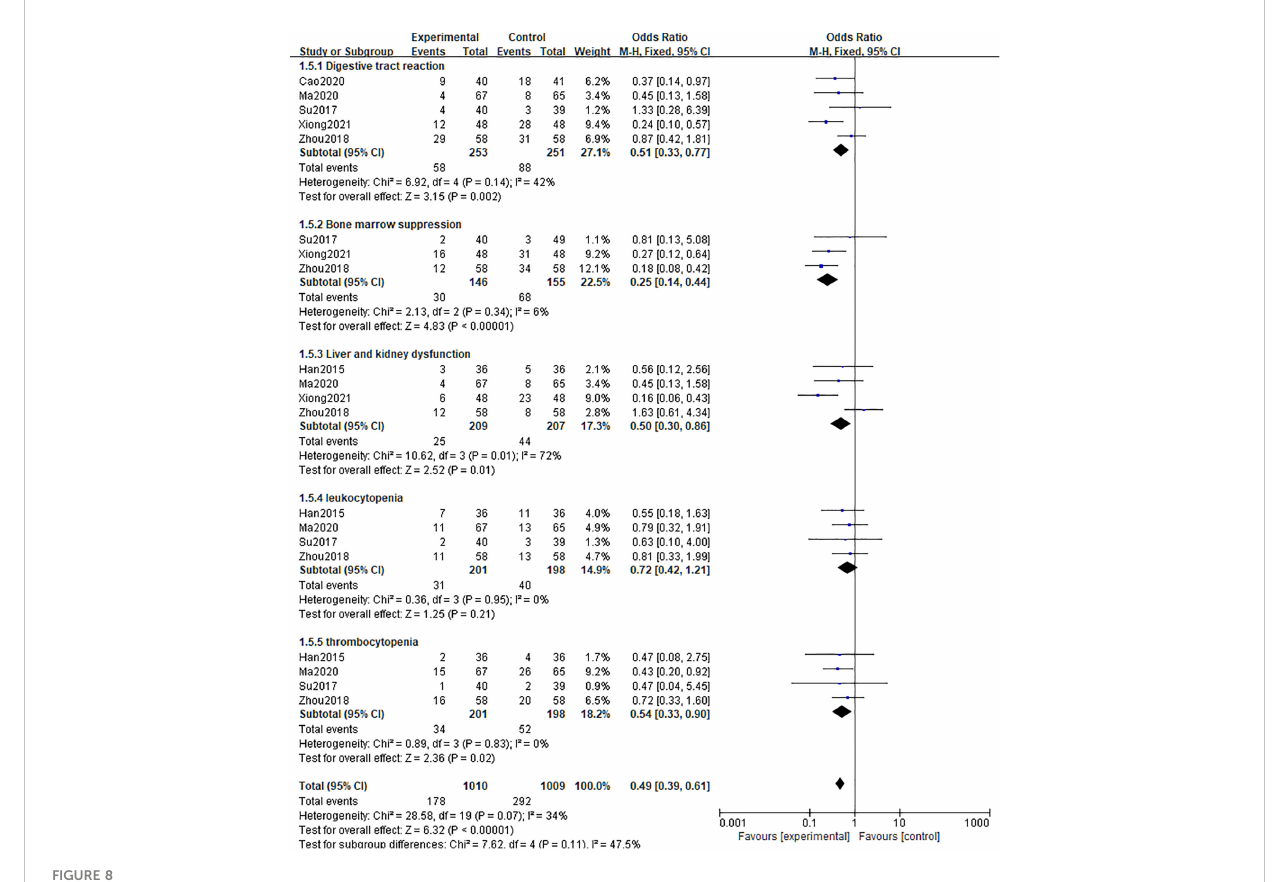
FIGURE 8 Forest map with comparative incidence of adverse reactions.